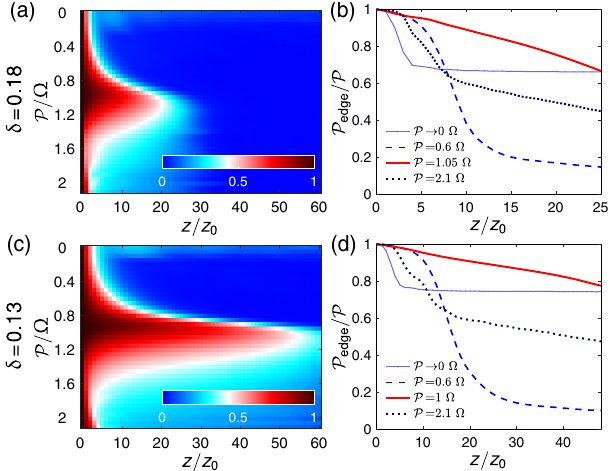
FIG. 6. IPR and power on the edge for two different values of δ . (a),(c) The variation of IPR, calculated after each driving period, as a function of renormalized power and propagation distance for δ ¼ 0 . 18 and 0.13, respectively. (b),(d) The variation of the fraction of total normalized power on the zigzag edge, for different values of renormalized powers indicated in the figures, corresponding to δ ¼ 0 . 18 and 0.13, respectively.